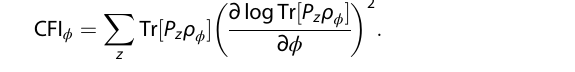
fi eld signal. During the Ramsey propagation 1 the spins accumulate a fi eld dependent phase for a time τ . Prior to the readout, a R rotation converts this phase into a signal-dependent P z expectation value. For the spin systems in which the dipolar interaction cannot